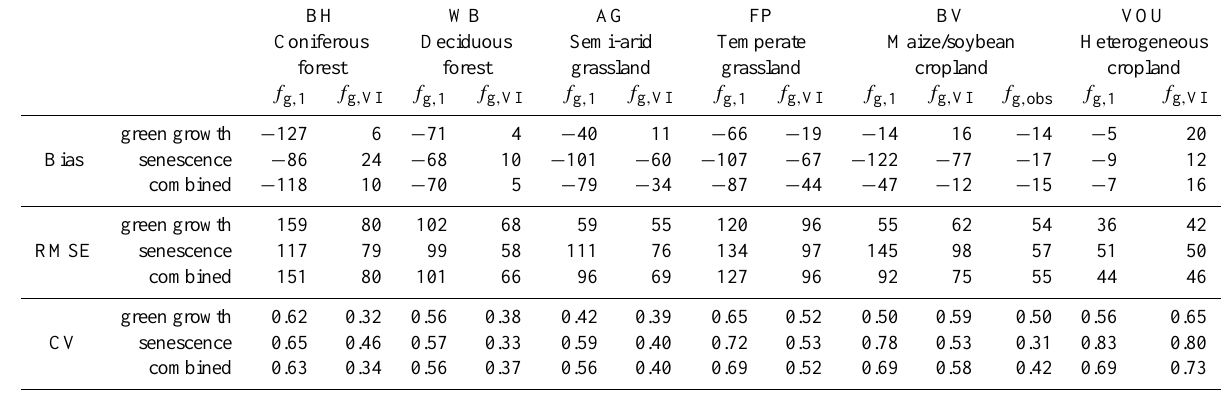
Table 2. Bias (modelled − observed) and RMSE in W m − 2 and CV (unitless) of instantaneous modelled sensible heat flux at noon for fluxes during the growing season, senescence and the combined period, and using f g = 1 ( f g , 1 ), or f g adjusted based on VI ( f g , VI ), or based on observations ( f g,obs ). Model runs used t 0 at one hour after sunrise and were driven primarily by ground-based observations. MODIS products were used to estimate f g , VI at all sites and LAI at VOU.